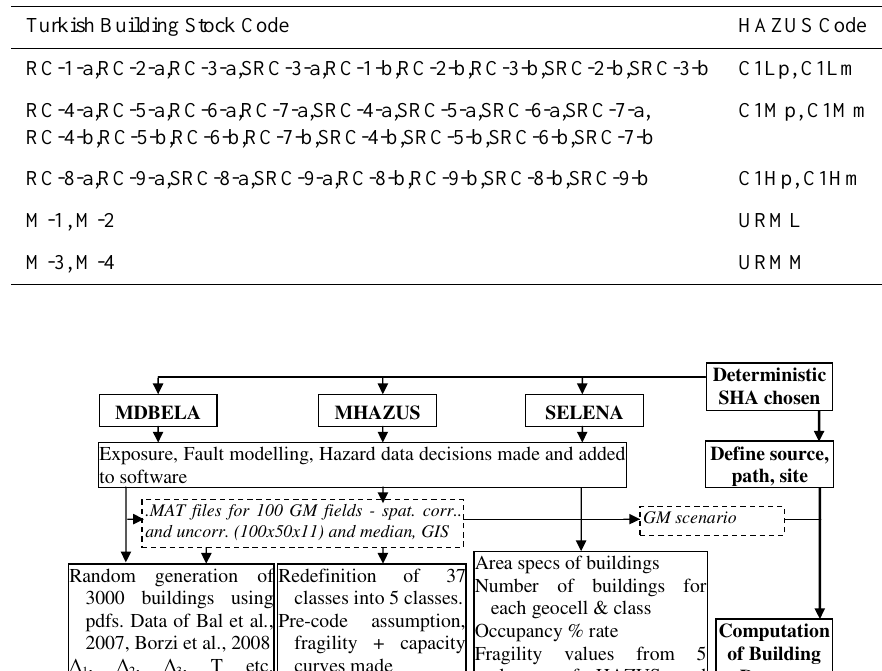
Table 2. Building damage % in HAZUS-based codes for the 3 ELE packages.